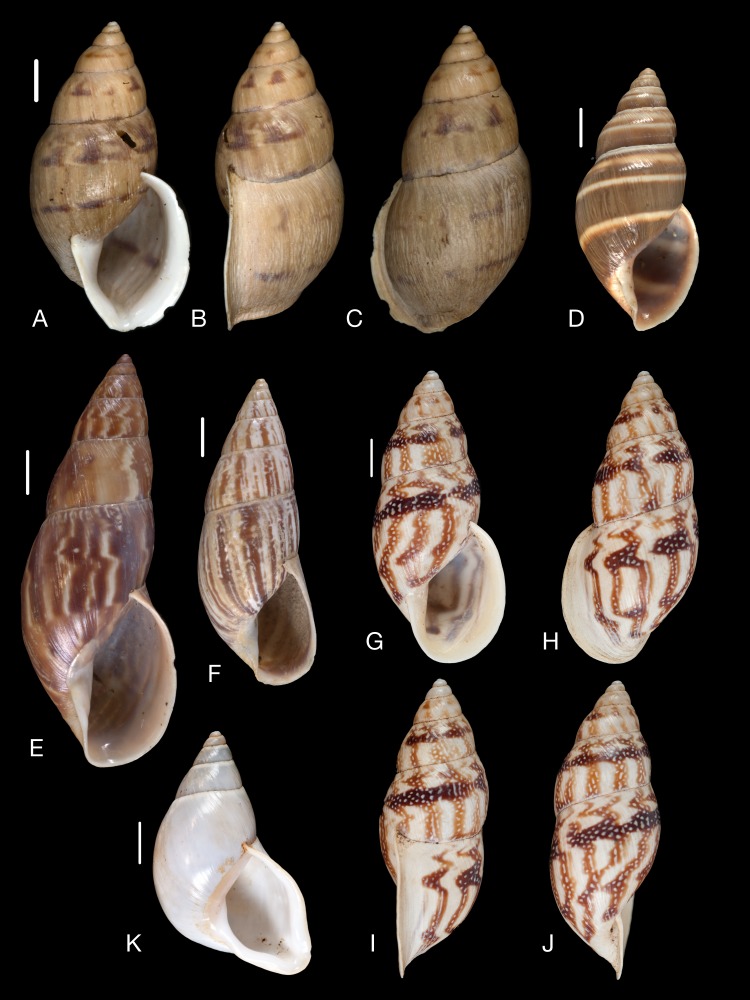
Material collected by the CCP.(A–K) Bulimulidae. Drymaeus (Drymaeus) chanchamayensis (Hidalgo, 1870), MNCN 15.05/3157, (A) ventral view, (B) lateral view (lip), (C) dorsal view; Drymaeus (Drymaeus) chimborasensis (Reeve, 1848), MNCN 15.05/13426, (D) ventral view; Drymaeus (Drymaeus) chrysomelas (Martens, 1867), MNCN 15.05/13461, (E) ventral view; Drymaeus (Drymaeus) trujillensis (Philippi, 1867), MNCN 15.05/13679, (F) ventral view; Drymaeus (Drymaeus) membielinus (Crosse, 1867), MNCN 15.05/7355, (G) ventral view, (H) lateral view (lip), (I) lateral view (umbilicus), (J) dorsal view; Drymaeus (Drymaeus) fallax (Pfeiffer, 1853), MNCN 15.05/13148, (K) ventral view. Scale line 5 mm.